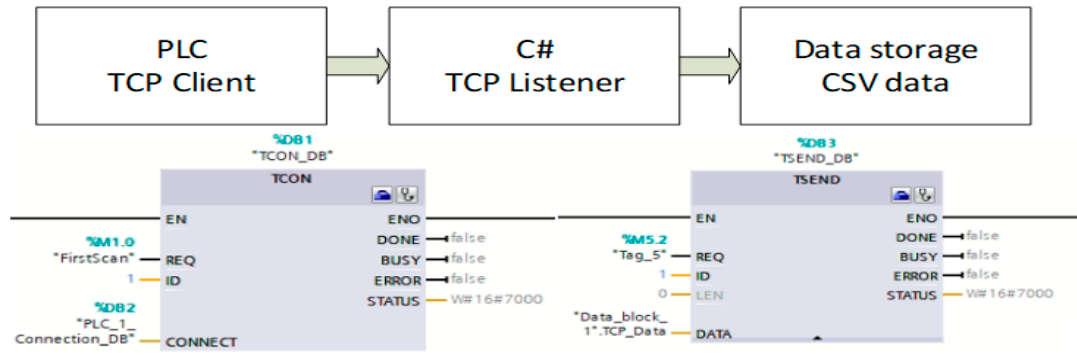
Figure 5. Client communication in PLC system.